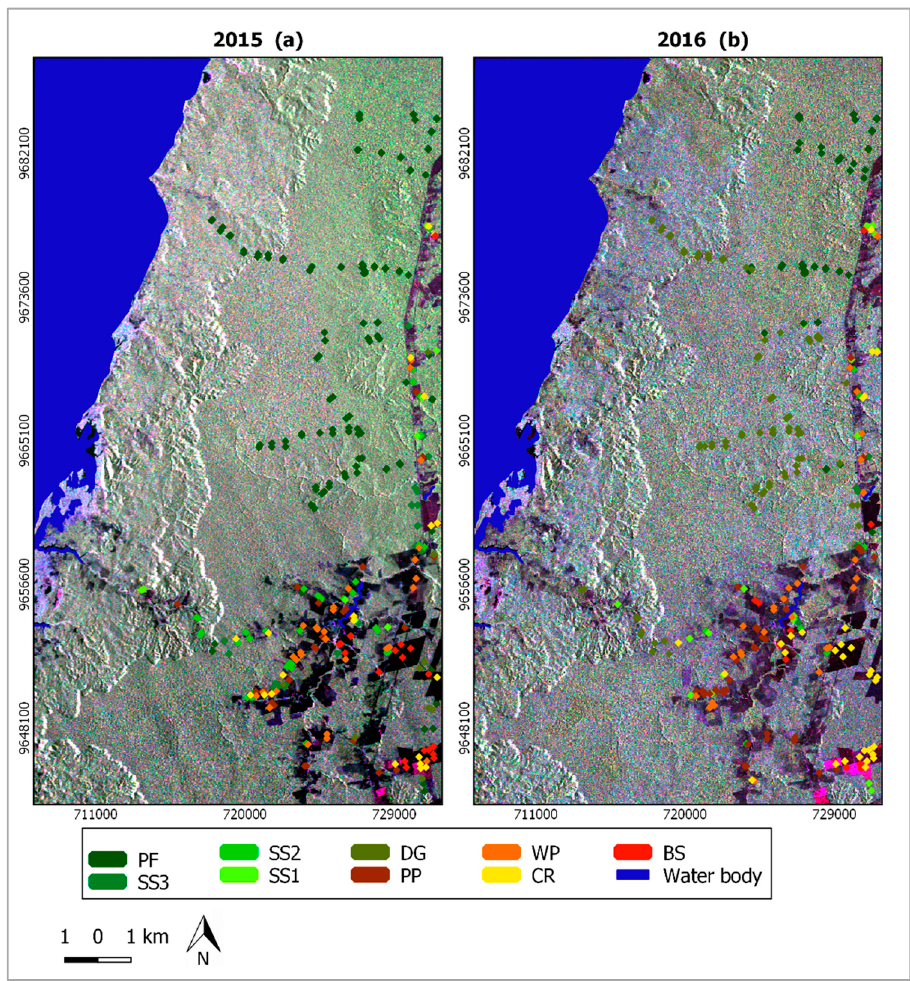
Figure 4. Distribution of the ground truths over the nine land use and land cover (LULC) classes found in the study area and represented in the ALOS/PALSAR-2 images from 2015 ( a ) and 2016 ( b ). For LULC class identification, see Table 1.